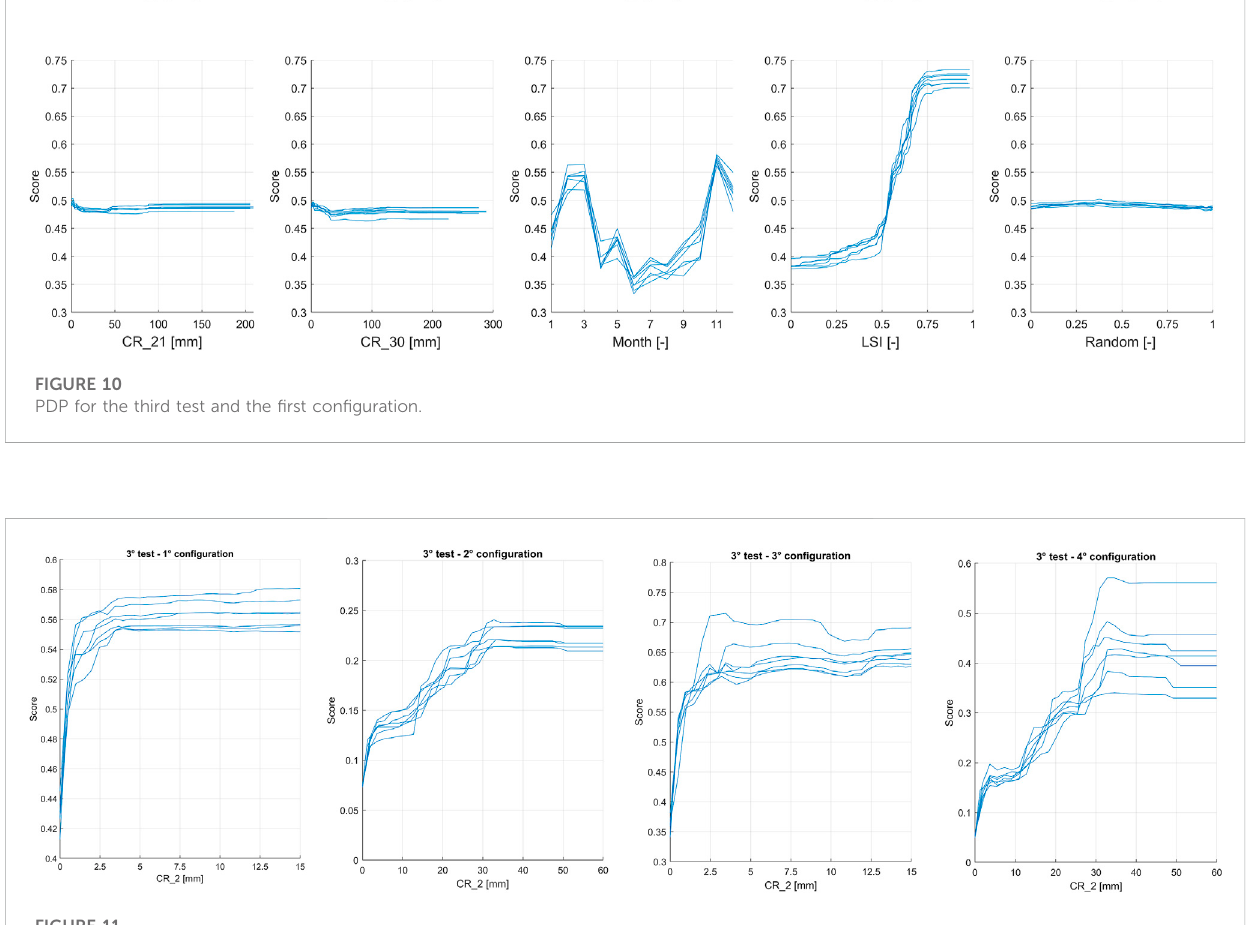
FIGURE 11 PDPs obtained for variable CR_2, for the third test, for all con fi